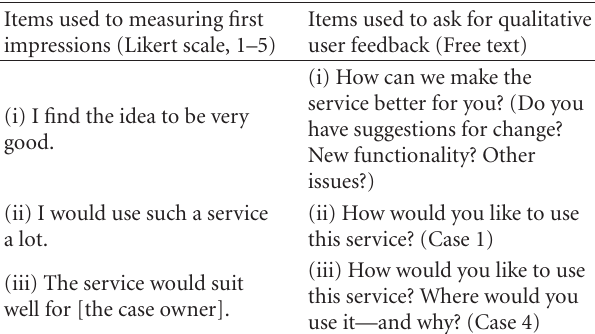
Table 2: Questionnaire items used to measure first impressions and ask for qualitative